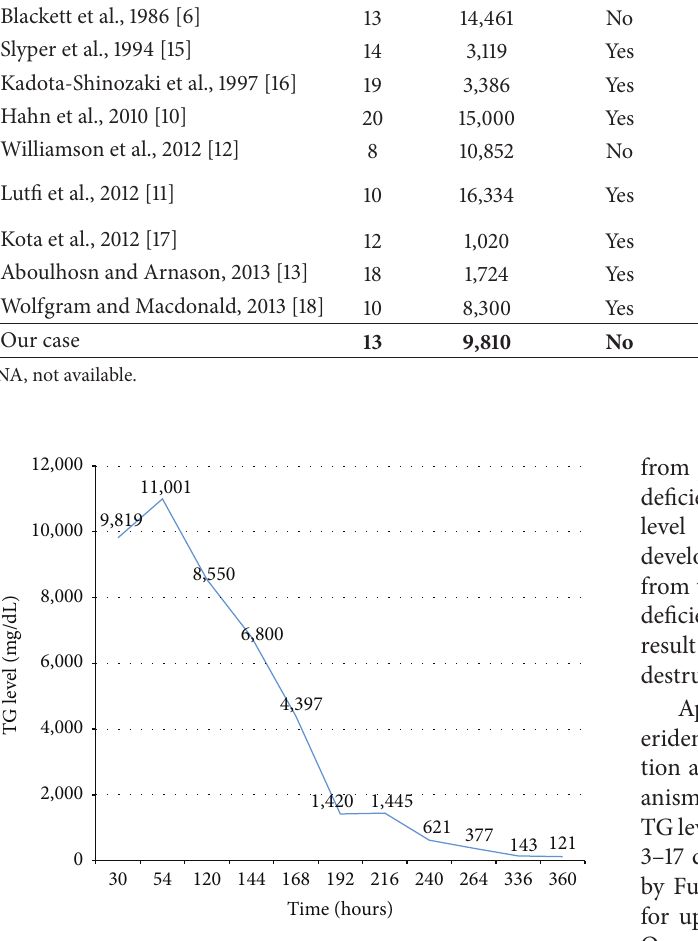
Figure 2: Triglyceride levels after DKA